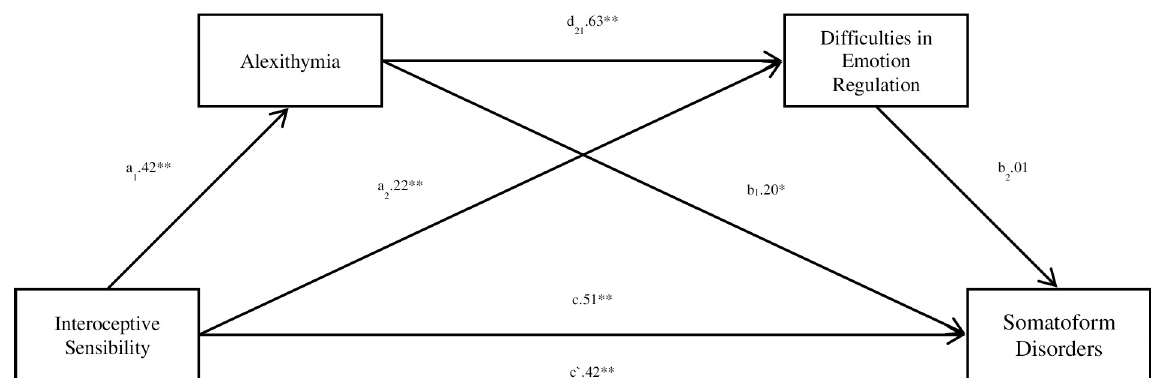
Fig 6. Serial multiple mediational model for the relation between an interoceptive sensibility (autonomic reactivity) and somatoform disorders, where alexithymia and difficulties in emotion regulation constitute mediators. (c) A direct effect of the impact of interoceptive sensibility on the somatoform disorders. (a1, b1) An indirect effect of the impact of interoceptive sensibility on the somatoform disorders, including alexithymia. (a2, b2) An indirect effect of the impact of interoceptive sensibility on the somatoform disorders, including Difficulties in Emotion Regulation. (a1, d21, b2) An indirect effect of the impact of interoceptive sensibility on the somatoform disorders, including Alexithymia and Difficulties in Emotion Regulation. (c‘) A direct effect of the impact of interoceptive sensibility on the somatoform disorders, taking account of the impact of both mediators. � -p < 0,05; �� -p < 0,01. Interoceptive sensibility (autonomic reactivity) was measured by Body Perception Questionnaire-Short Form (BPQ-SF). Somatoform disorders was measured by Somatoform Dissociation Questionnaire (SDQ-20). Difficulty in regulation emotion was measured by Difficulties in Emotion Regulation Scale (DERS). Alexithymia was measured by The Toronto Alexithymia Scale– 20